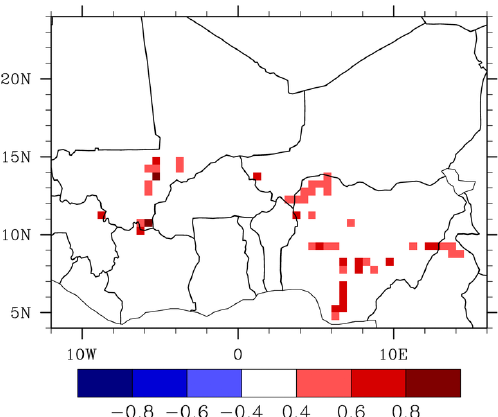
Fig. 9b. Spatial monthly correlation between ISBA-TRIP and CPP over 2002–2007.